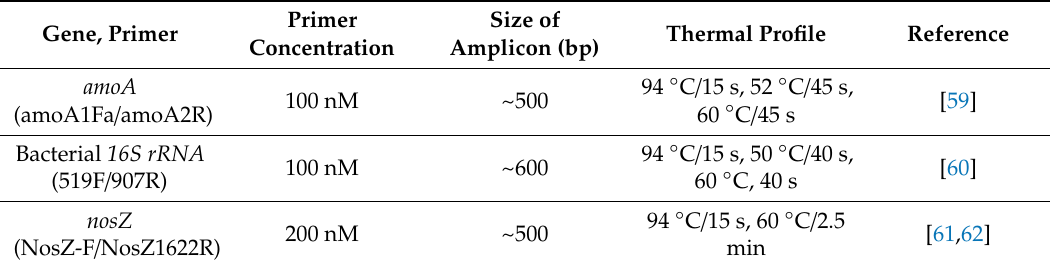
Table A1. Primers and conditions applied in real-time PCR.